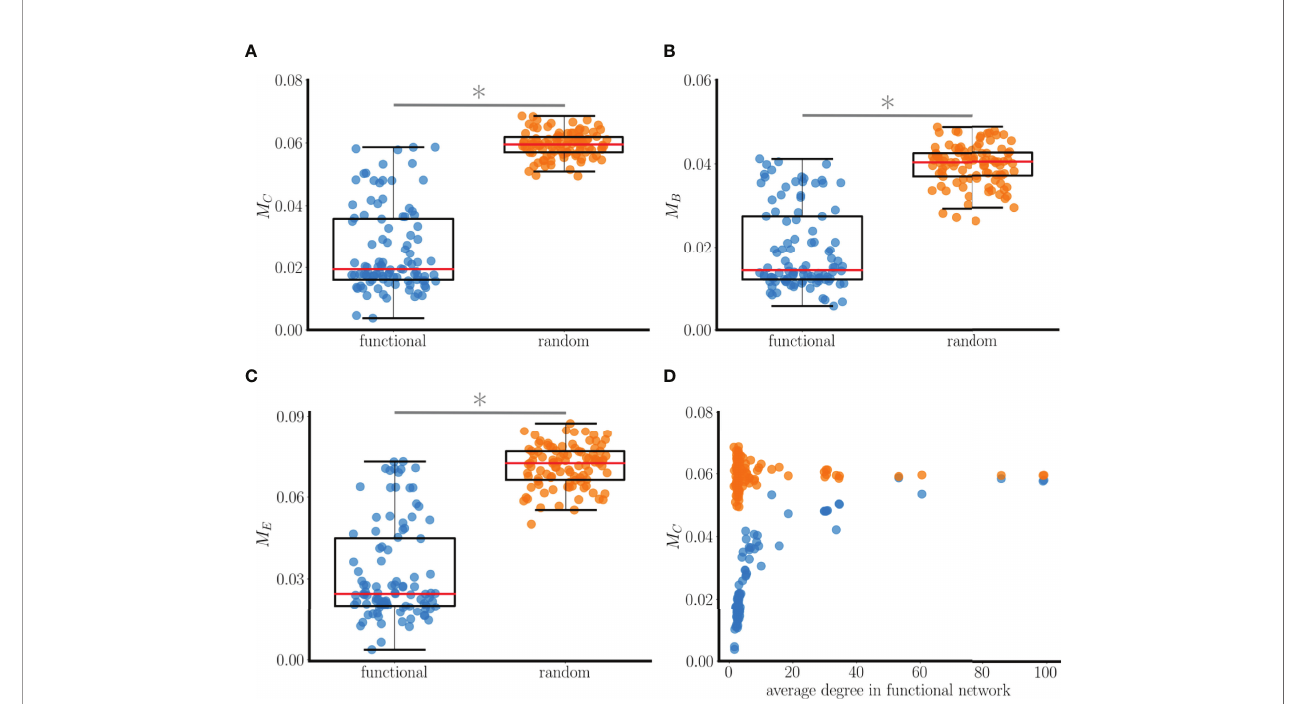
FIGURE 10 | Relationship between connectedness in a 100-node functional network and various centrality measures. The functional networks are based on 100 simulations with random initial conditions using the scale-free structural network of Figure 9 . (A) M C (closeness centrality difference) values computed from functional networks (blue points) and from random baseline networks (orange points). Low values mean similarity of closeness values in the structural network between neighboring nodes of the functional network. The median value of M C for the functional network is roughly a third that of the baseline network, and the difference in the distributions is signi fi cant (*: p<0.001 for signi fi cance, Wilcoxon test). (B) Comparison using a betweenness centrality metric M B . (C) Comparison using an eigenvector centrality metric M E . (D) The M C value is lower for the functional networks than the random baseline networks regardless of the average degree of the nodes in the functional networks.